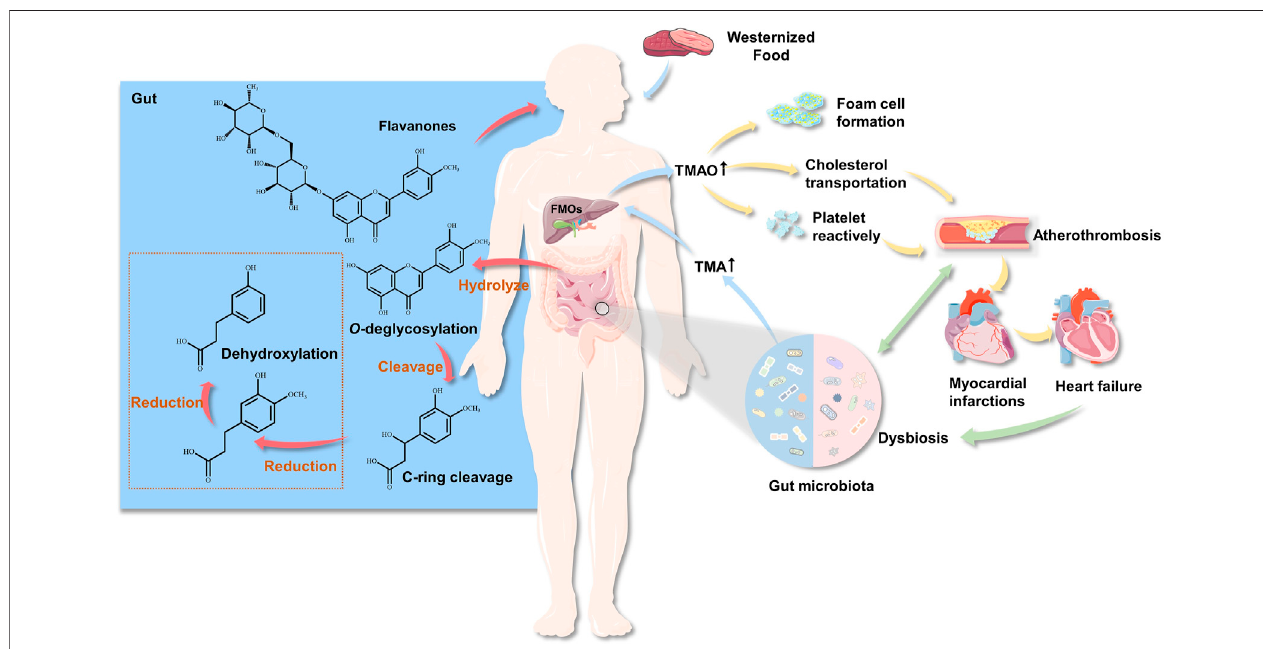
FIGURE 1 | The role of gut microbiota in cardiovascular disease and fl avonoid metabolism. The GM produces TMA by ingesting choline (such as choline, phosphatidylcholine and l – carnitine) from food. TMA enters the liver through the hepatointestinal circulation, and forms TMAO through the oxidation of fl avin monooxygenase, then enters the systemic circulation. Circulating TMAO levels increase, causing foam cells and platelets to accumulate, while affecting cholesterol transport, thereby promoting atheromatous plaque formation.